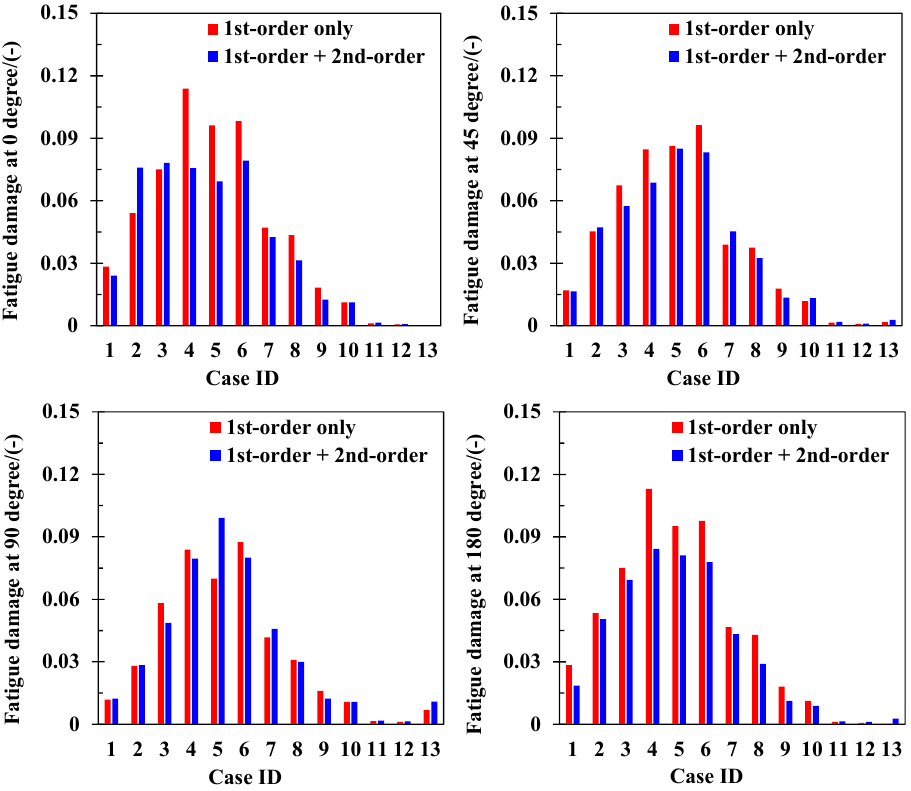
Figure 14. Fatigue damage at different tower-base locations of each load case over 25 years.